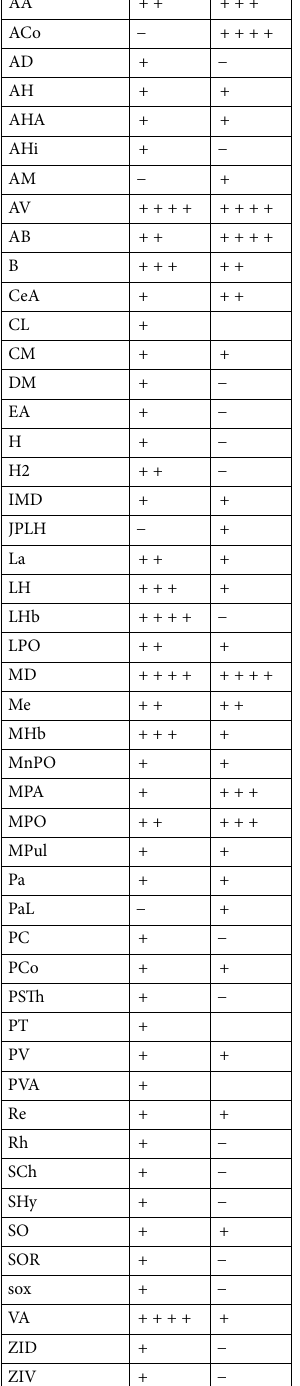
Table 1. Summary of semiquantitative results on the appearance of fibers in subcortical areas/nuclei, discriminated by A 32 and A 25 cortices. + : Isolated axons; + + : Low presence of fibers; + + + : moderate presence of fibers; + + + + : high presence of